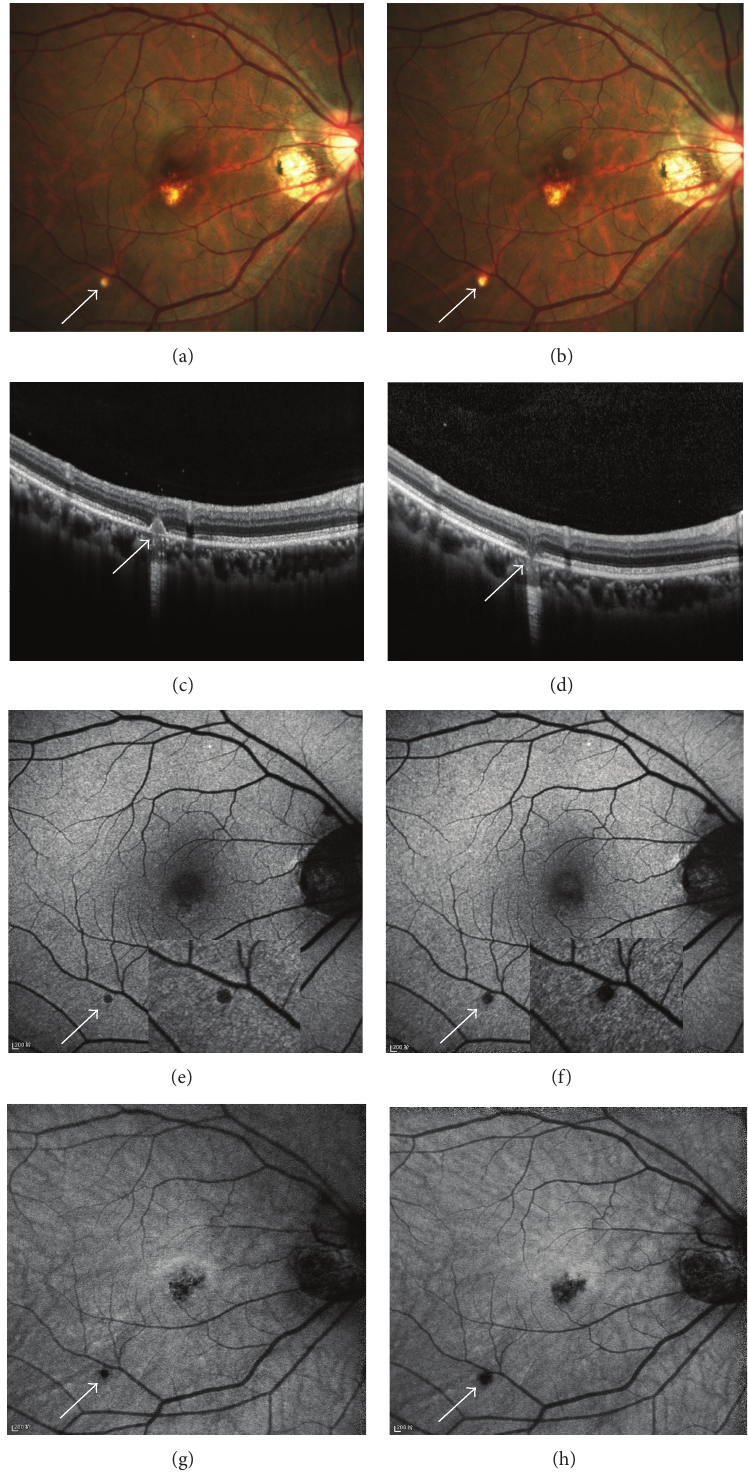
Figure 1: The presence of hypoautofluorescent spot with hyperautofluorescent margin on FAF imaging (e, f, g, and h) and corresponding findings on fundus photography (a, b) and SD-OCT (c, d). (a) A yellow-white creamy spot was shown on fundus photography. (c) SD- OCT revealed a hump-shaped chorioretinal nodule of moderate reflectivity breaking through RPE and Bruch’s membrane (BM), beneath the OPL. Hyperautofluorescent margin was detected with SW-FAF imaging (e), while it was not obvious on NIR-FAF (g). Six weeks later, (b) the spot became larger on fundus photography. (d) On SD-OCT, the nodule regressed from the apex toward the choroidal part. (f) The hyperautofluorescent margin on SW-FAF disappeared. (h) The hypoautofluorescent spot on NIR-FAF